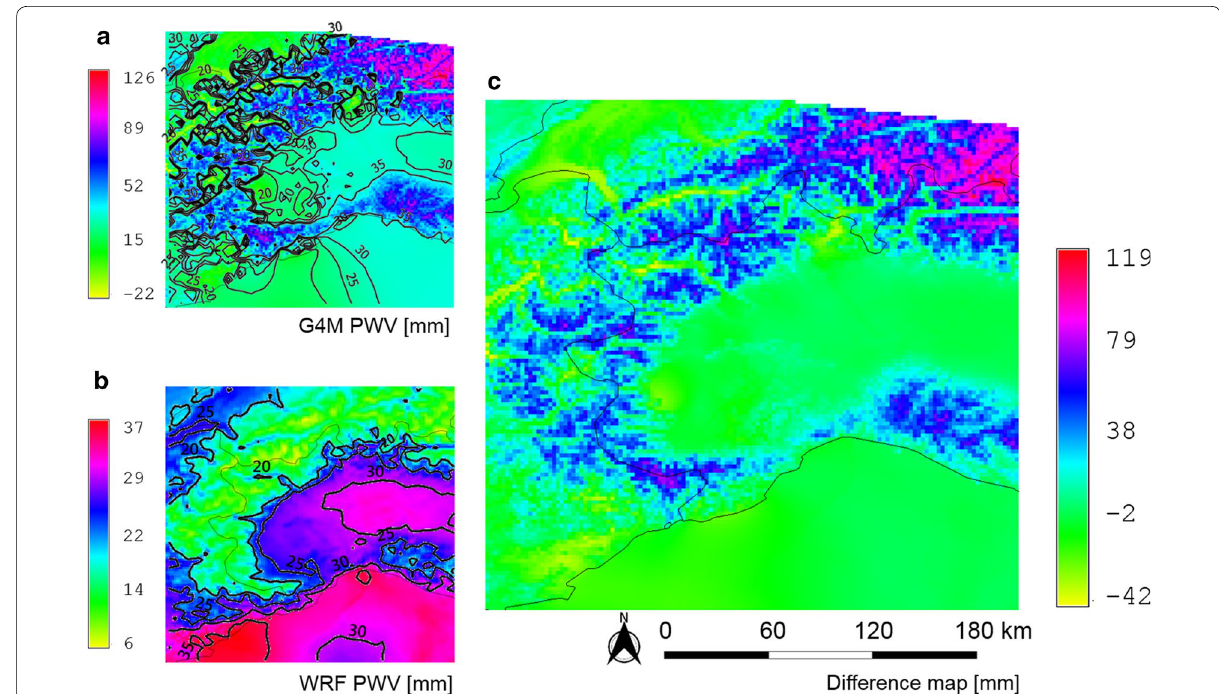
Fig. 4 PWV map from the G4M procedure ( a ). The orographic effect is evident in elevated areas. b represents the WRF PWV map and c depicts the PWV difference map (G4M-WRF). Large differences are mainly observed in elevated areas (Alps and Apennines). The maps refer to November 4, 2011, 10:00 UTC. The contour lines correspond to PWV values of 20, 25, 30, and 35